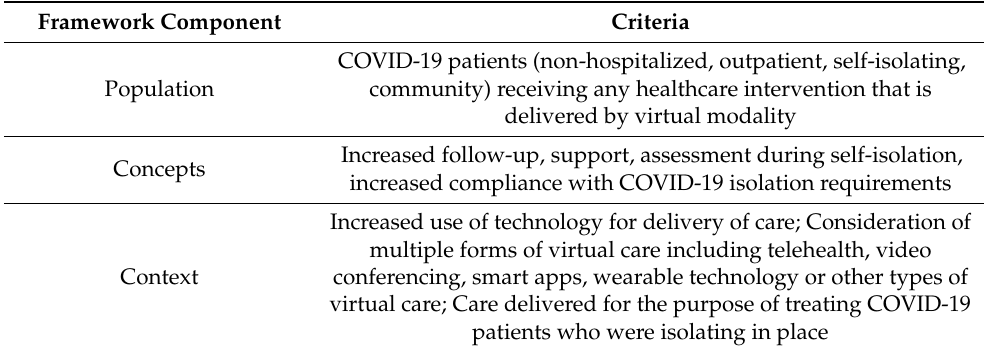
Table 1. Population, Concept and Context (PCC) framework. Framework